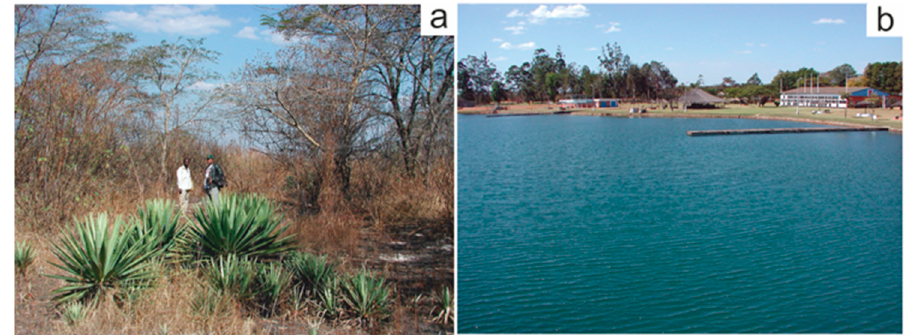
Figure 14. ( a ) An example of the spontaneous revegetation of an old overburden dump in the Minambe region, north of Mufulira, Zambian Copperbelt. ( b ) A successful water remediation of the abandoned Mindolo slimes deposit, west of Kitwe, Zambian Copperbelt ( b ). Photographs by Bohdan K ř íbek.